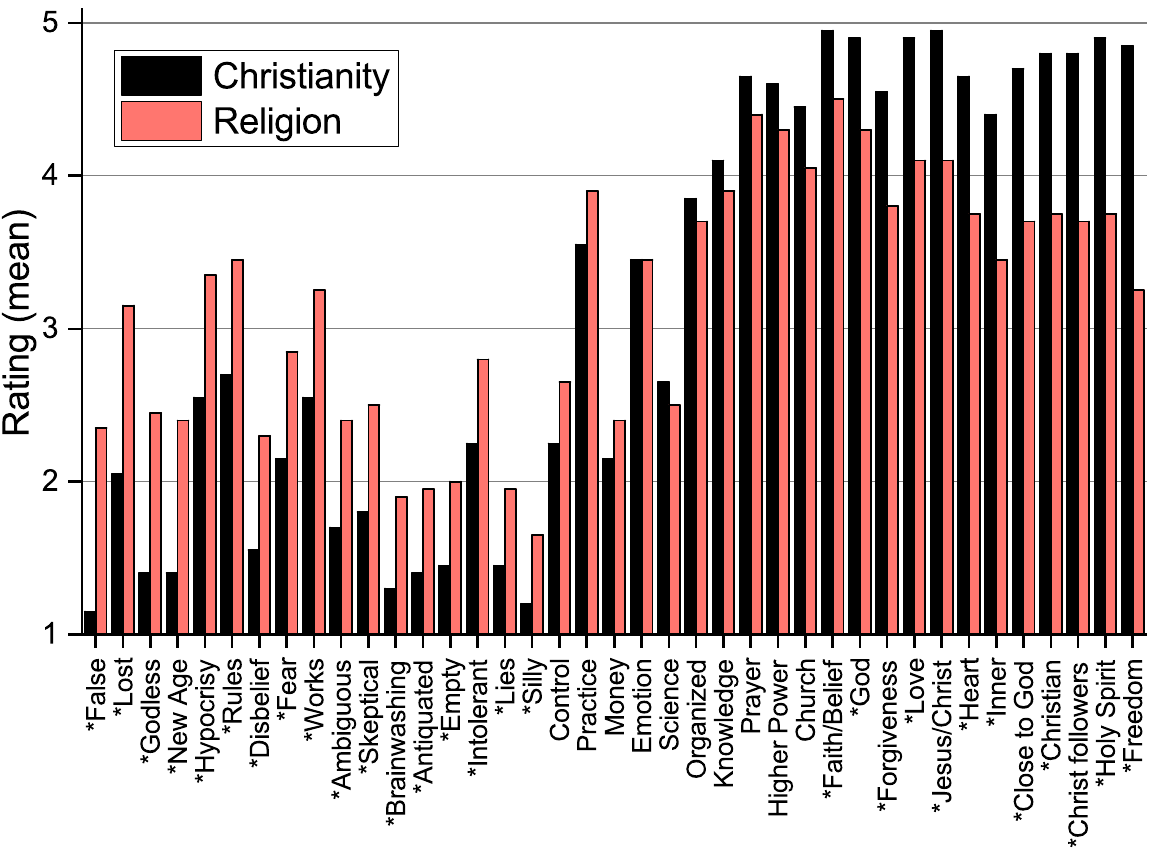
Figure 2: Evangelicals’ mean ratings of words describing “Christianity” and “religion.” * p < 0.05 (two-tailed), from t-test on difference between "Christianity" and